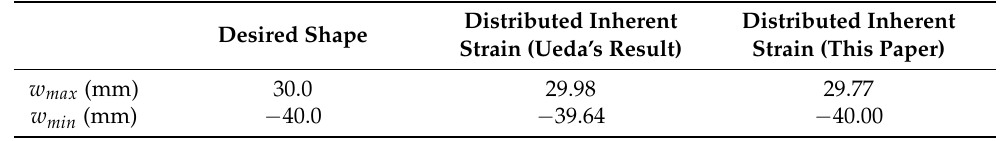
Figure 13. Orthogonal inherent strain using the proposed method ( a ) membrane strain, ( b ) bending strain (top surface). Table 4. Geometry error comparison.